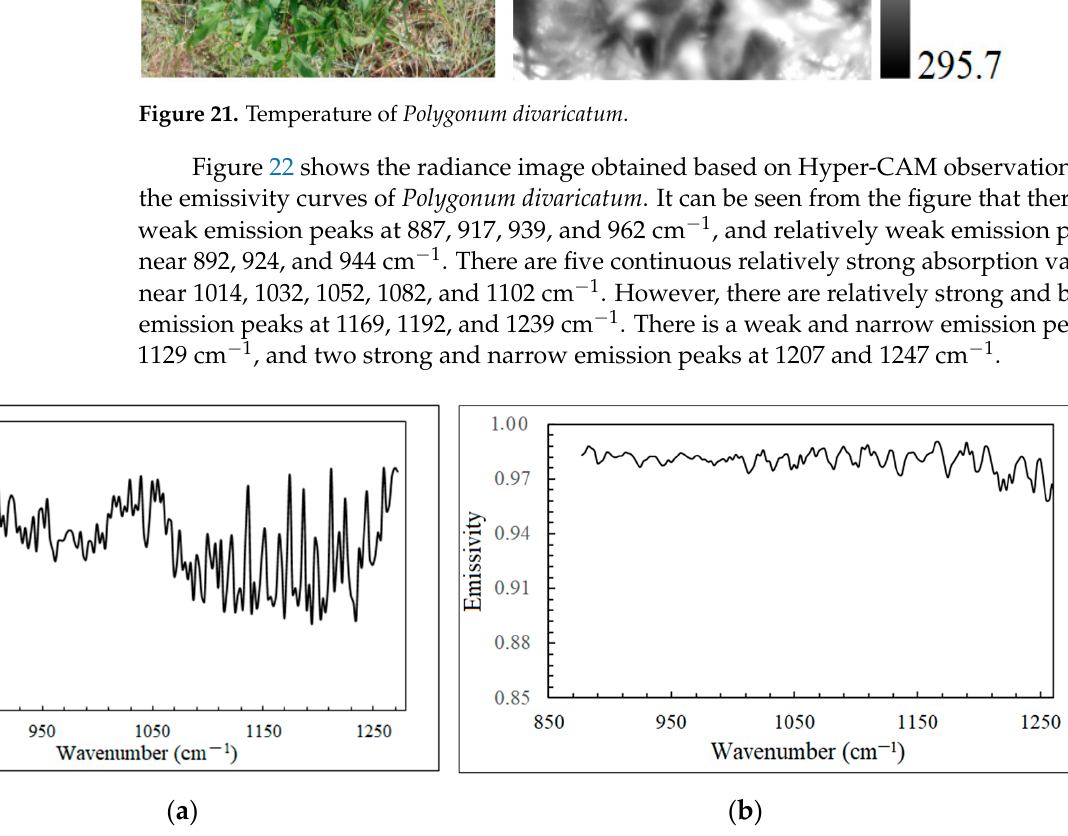
Figure 22. Results of emissivity retrieval and the down-welling radiance. ( a ) is the down-welling radiance retrieved from the gold-plate, and ( b ) the emissivity of Polygonum